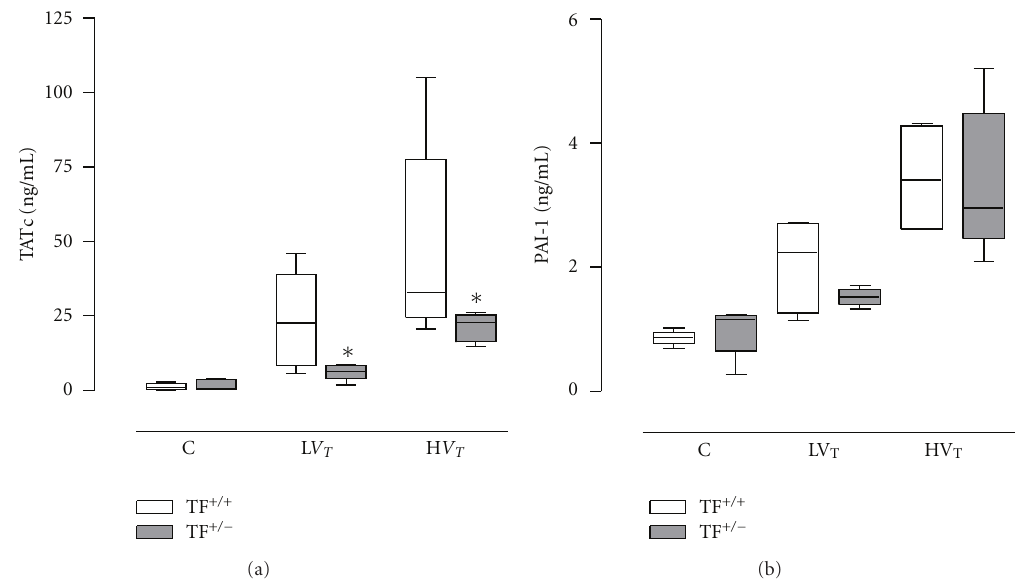
Figure 2: Bronchoalveolar lavage fluid thrombin-antithrombin complex (TATc) and plasminogen activator inhibitor (PAI)-1 levels in con- trol mice (C) and mice ventilated for 5 hours with lower tidal volumes (L V T ) or higher V T (H V T ). Each group consisted of heterozygote TF knockout mice (TF + / − ) and their wild-type littermates (TF + / + ). Data represent medians and interquartile range of six mice. ∗ P < 0 . 05 versus TF + / +